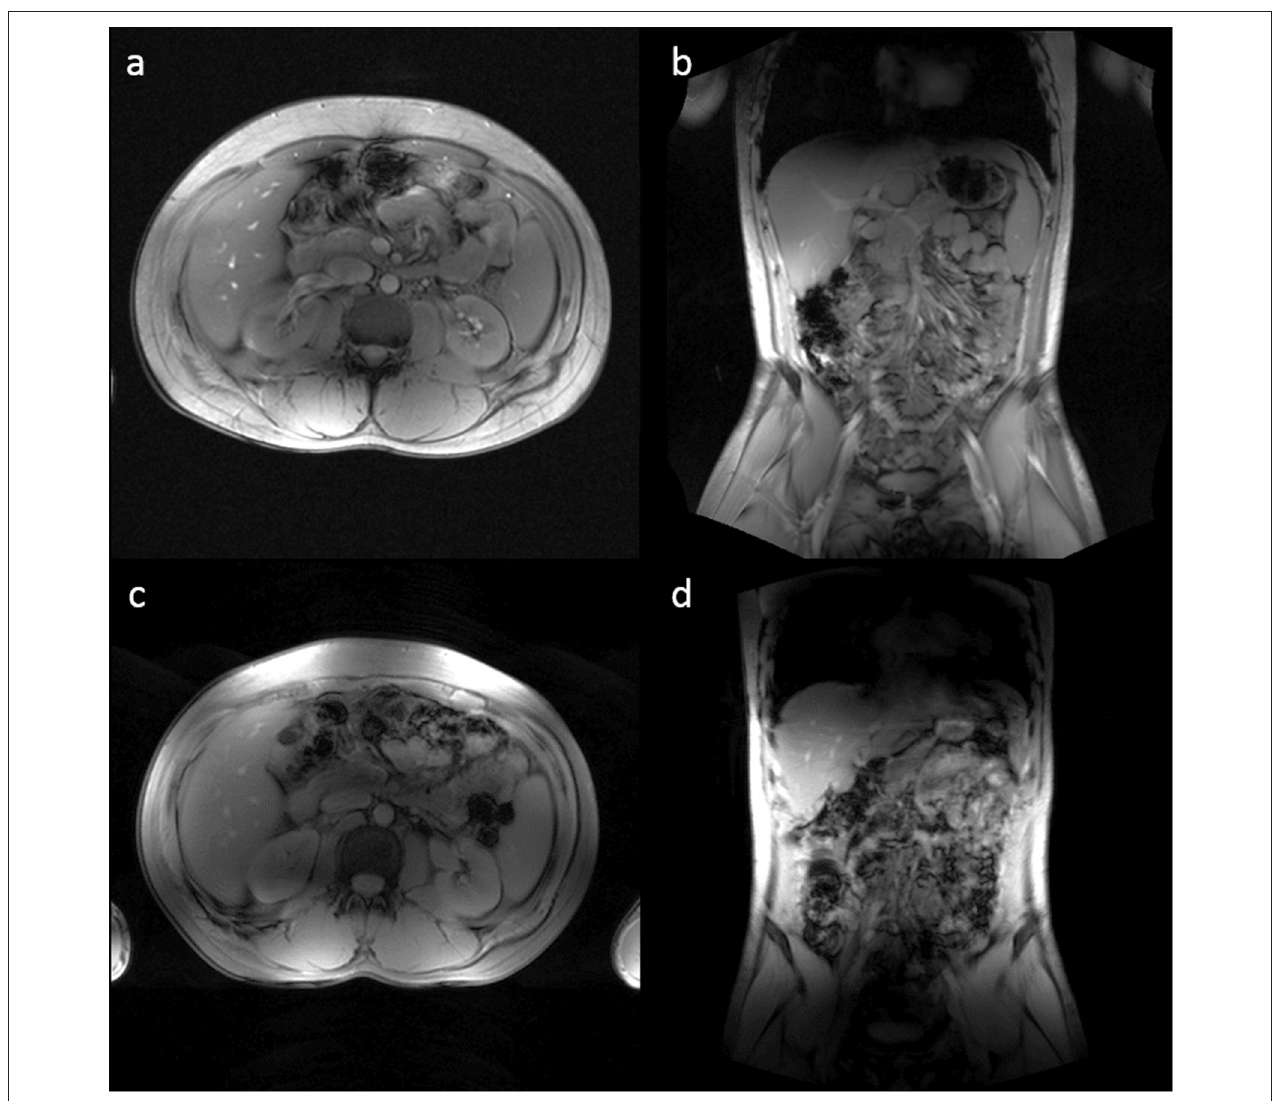
FIGURE 6 | In vivo images of a male volunteer acquired with (a,b) the integrated body coil and (c,d) the local body coil. The axial slices (a,c) have a field of view of 350 by 350 cm. The coronal slices (b,d) have a field of view of 500 by 500 mm. The images appear subjectively quite homogeneous even though they were acquired only with static RF shims to improve uniformity and no intensity correction was